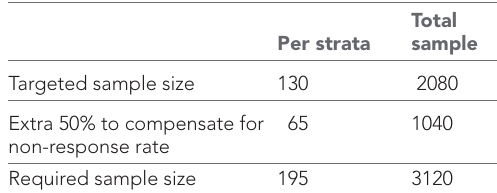
Table 2 Sample size per population strata